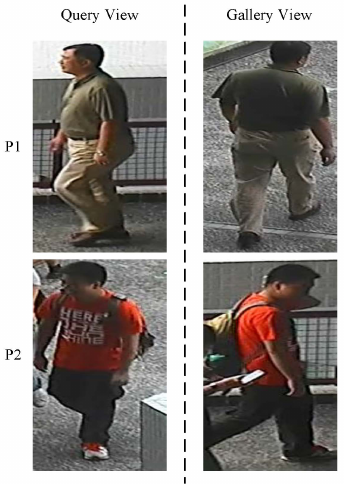
Figure 8. In Setting#1 it can be seen the matches of all Queries exist in the Gallery View, while the match for each person Seen in VIPeR domain is found from the Gallery of VIPeR domain domain.